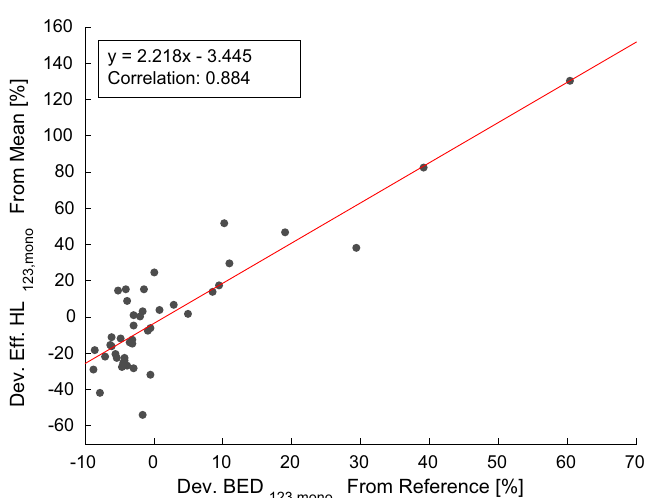
Fig. 4 Correlation between the deviation of the BED 123,mono from the reference model and the deviation of the effective half-life (HL) from the mean of each patient for all lesions